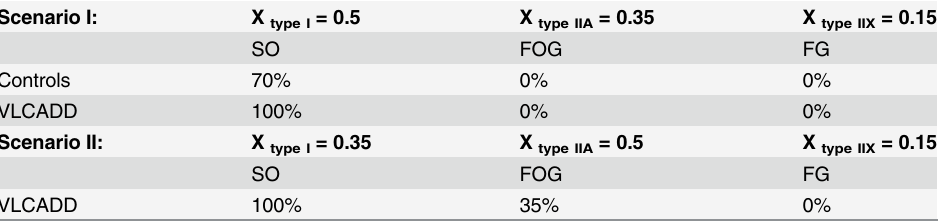
Table 5. results of model simulations of motor unit recruitment (in % of total pool size) during volun- tary exercise at FATMAX in healthy control subjects and VLCADD patients. Scenario